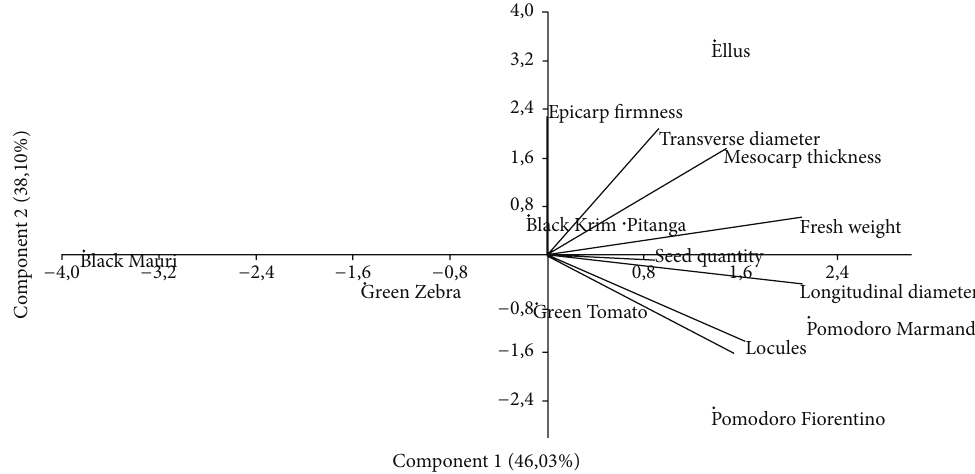
genotype Ellus. Meanwhile, low firmness of the epicarp was the best descriptor of fruit of the genotype Green